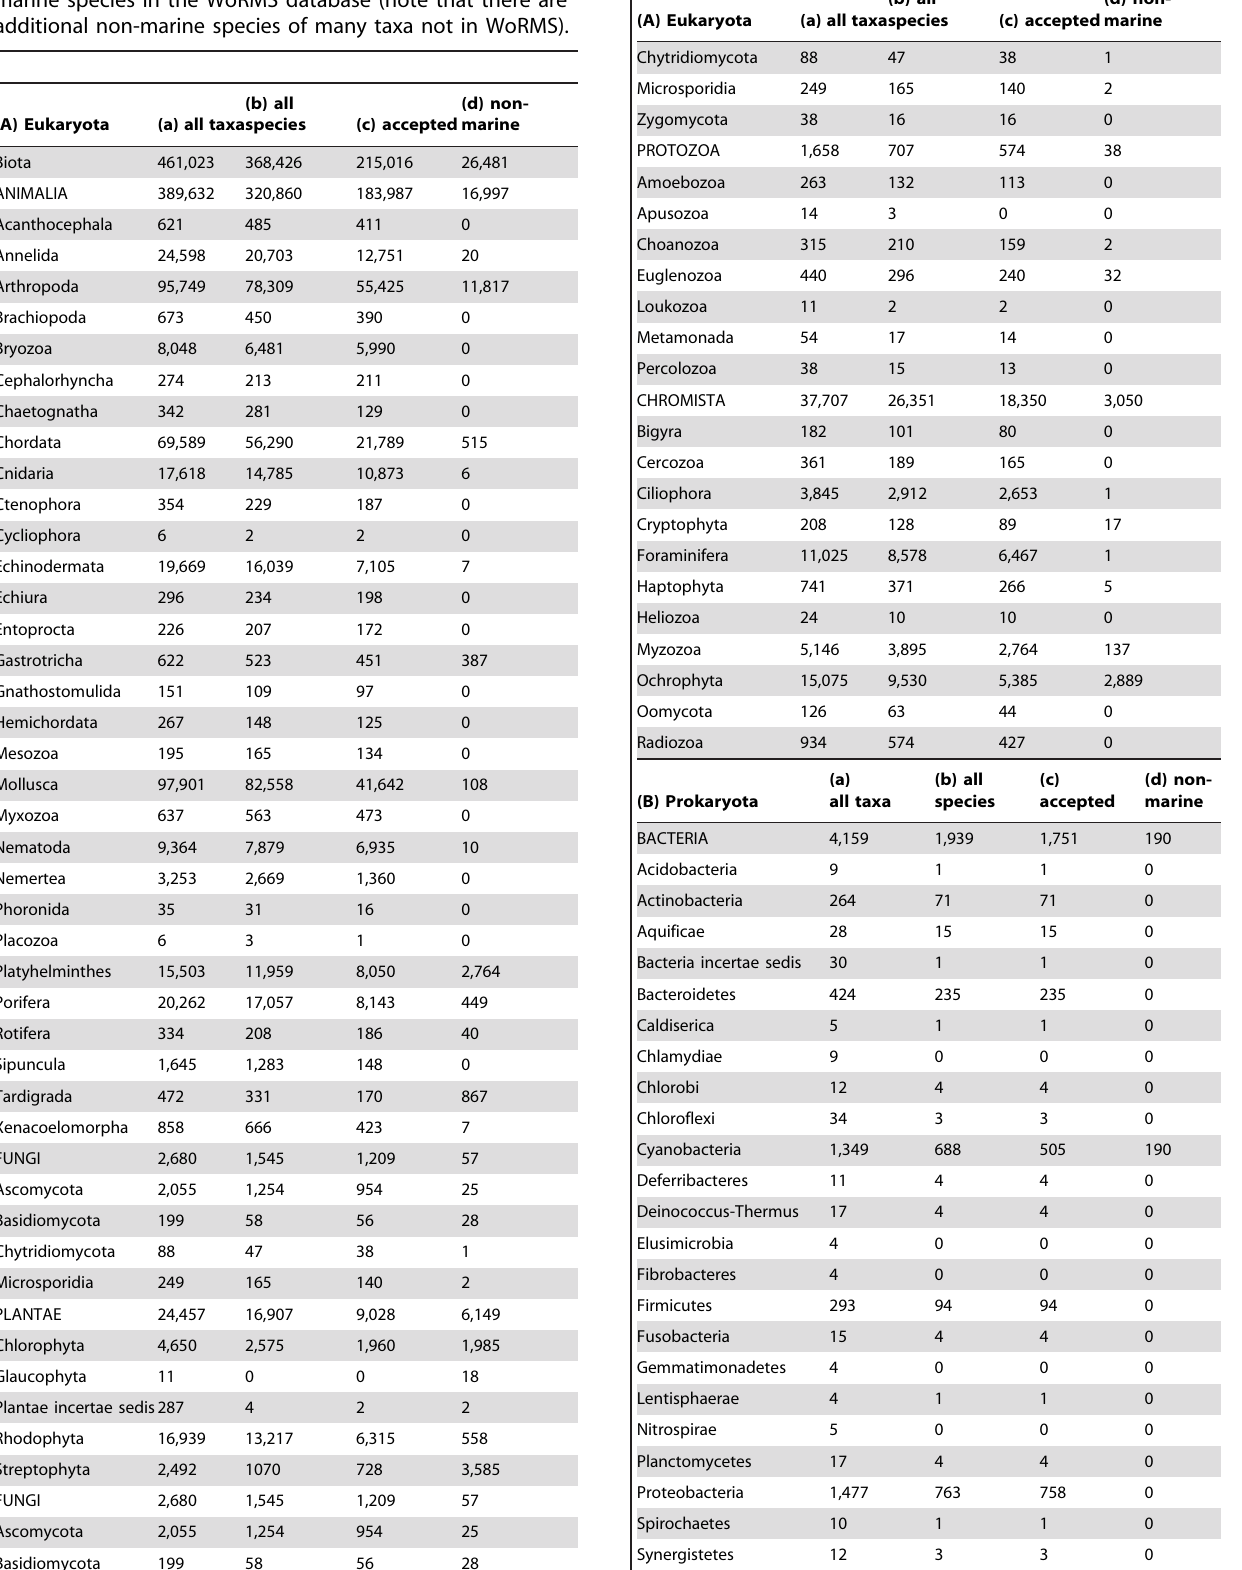
Table 5. The number of marine (a) taxa (infra-species and above), (b) species names (includes synonyms), (c) accepted species names (excluding synonyms); and (d) additional non- marine species in the WoRMS database (note that there are additional non-marine species of many taxa not in